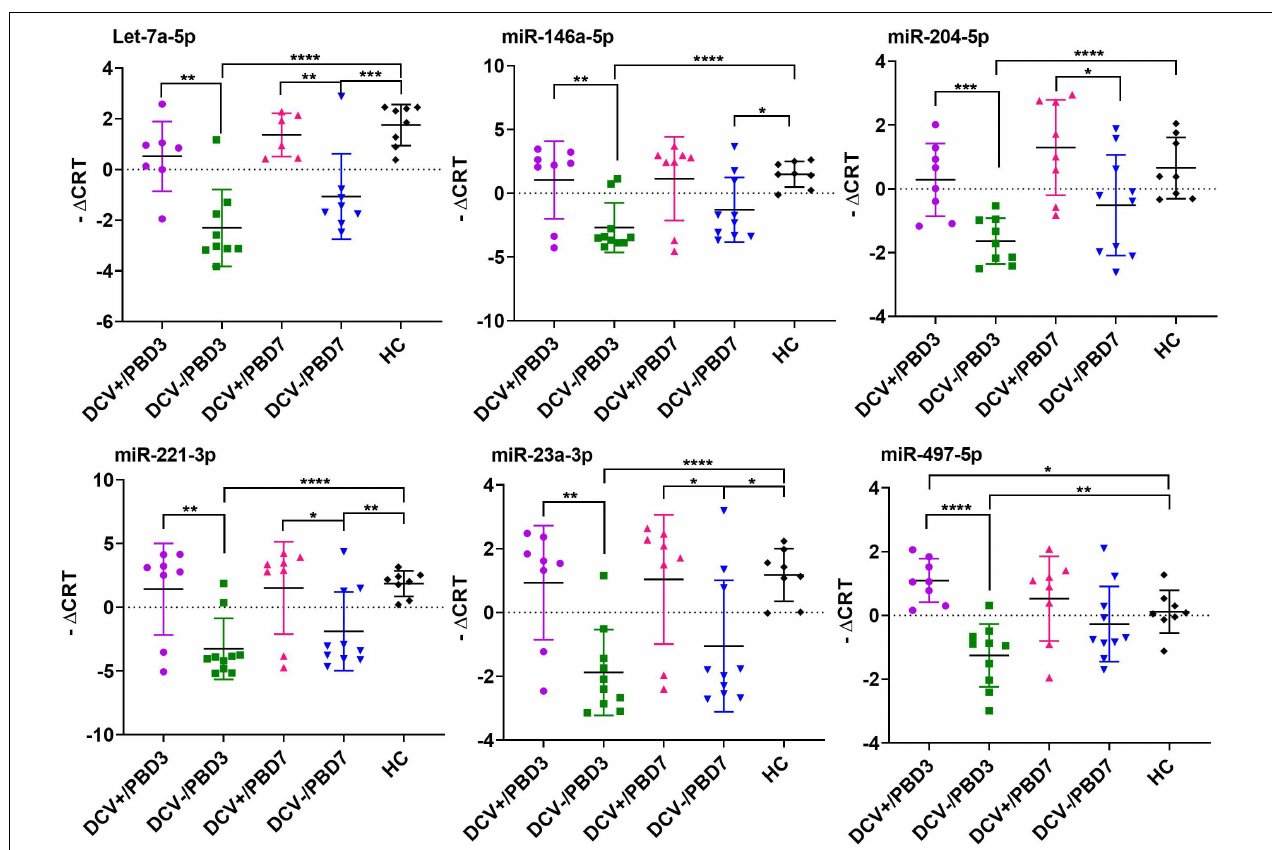
FIGURE 4 | Individual plasma miRNAs that showed highly differential expression in DCV+, DCV–, and HC groups. The differential miRNA expression levels are expressed as – (cid:49) C RT and a two tailed Student’s t -test was used to evaluate the difference between groups. Significant levels expressed as: **** p < 0.0001;